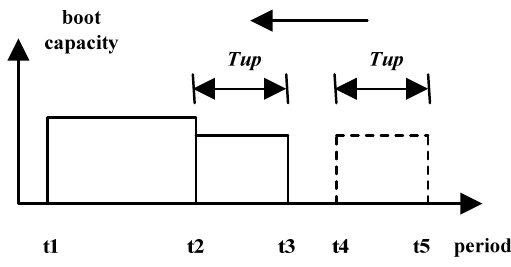
Figure 4. Sketch map of the single station boot peak combination.